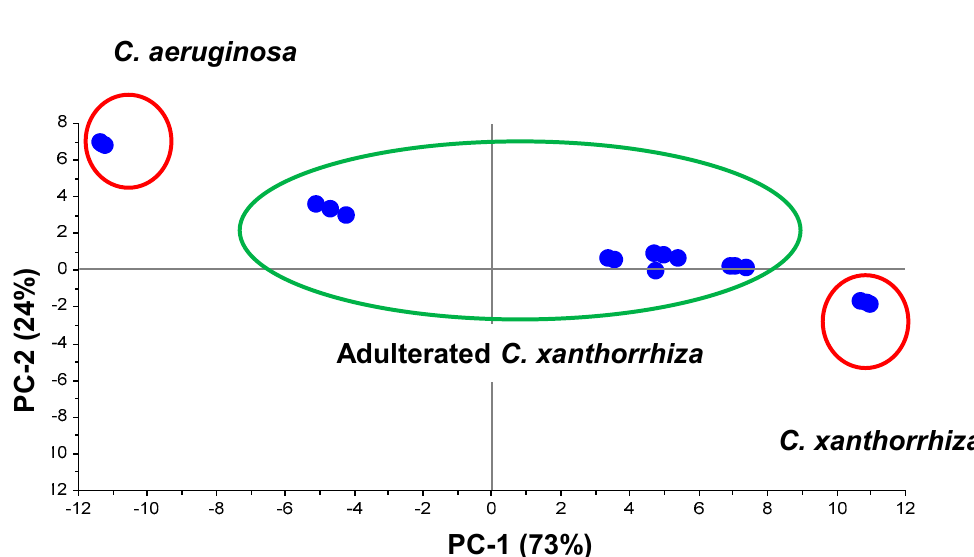
Figure 5. PCA score plot of pure C. xanthorrhiza , adulterated C. xanthorrhiza , and pure C. aeruginosa.